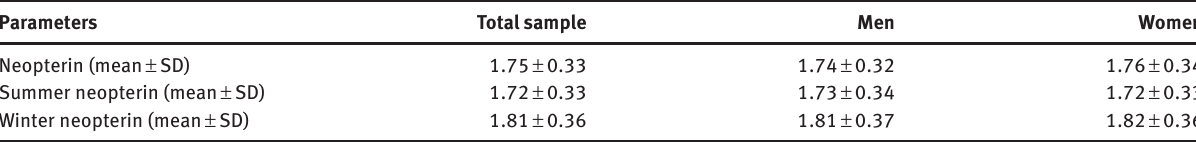
Table 2: Neopterin levels (nmol/L) in winter and summer in the total sample, men and women. Parameters